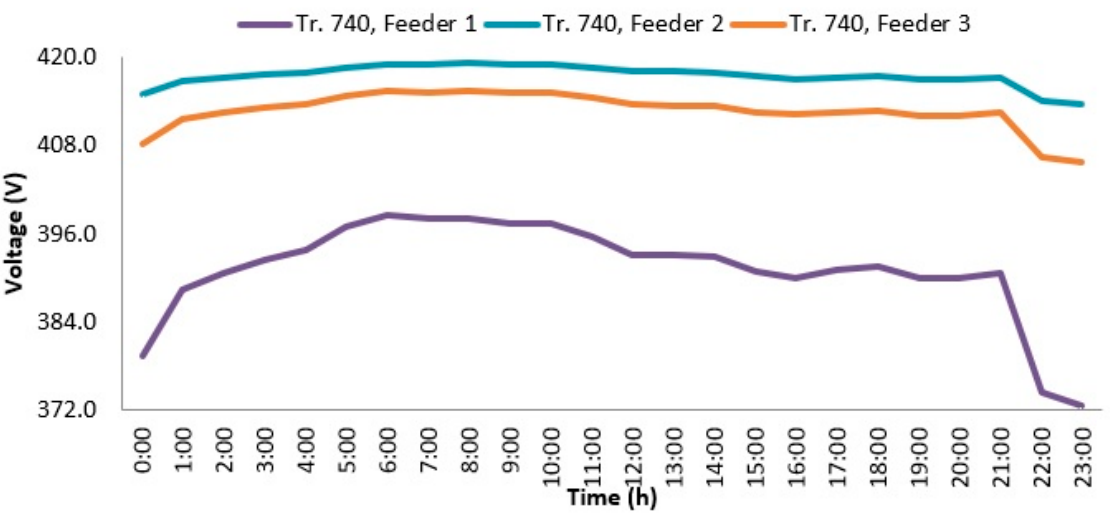
Figure 16. Load profiles of Transformer 740 in summer with 60% EVC and off-peak charging.